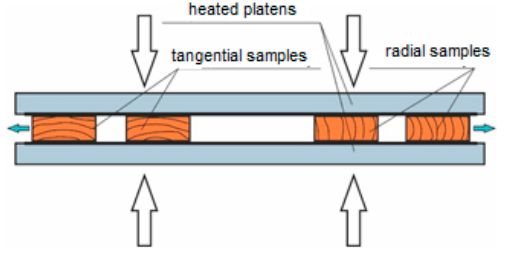
Figure 2. Scheme of sample storage during contact-drying.